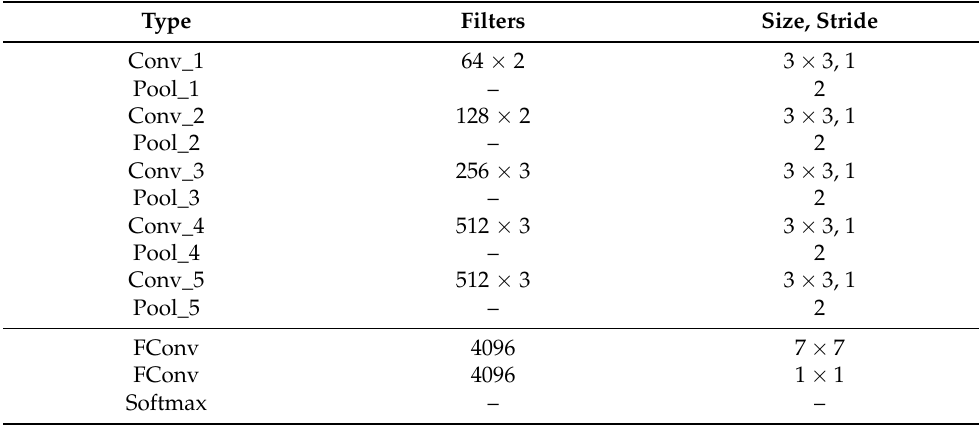
Table 1. Layer description of the VGG16.